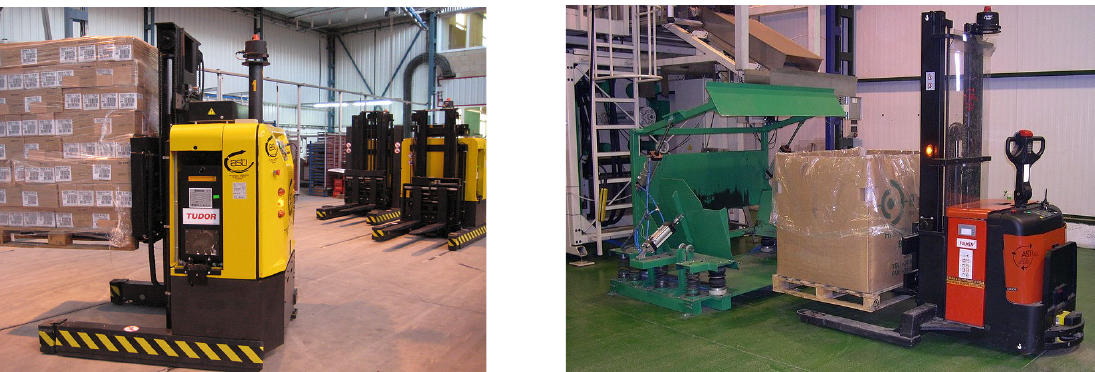
Figure 1. Examples of AGVs in industry